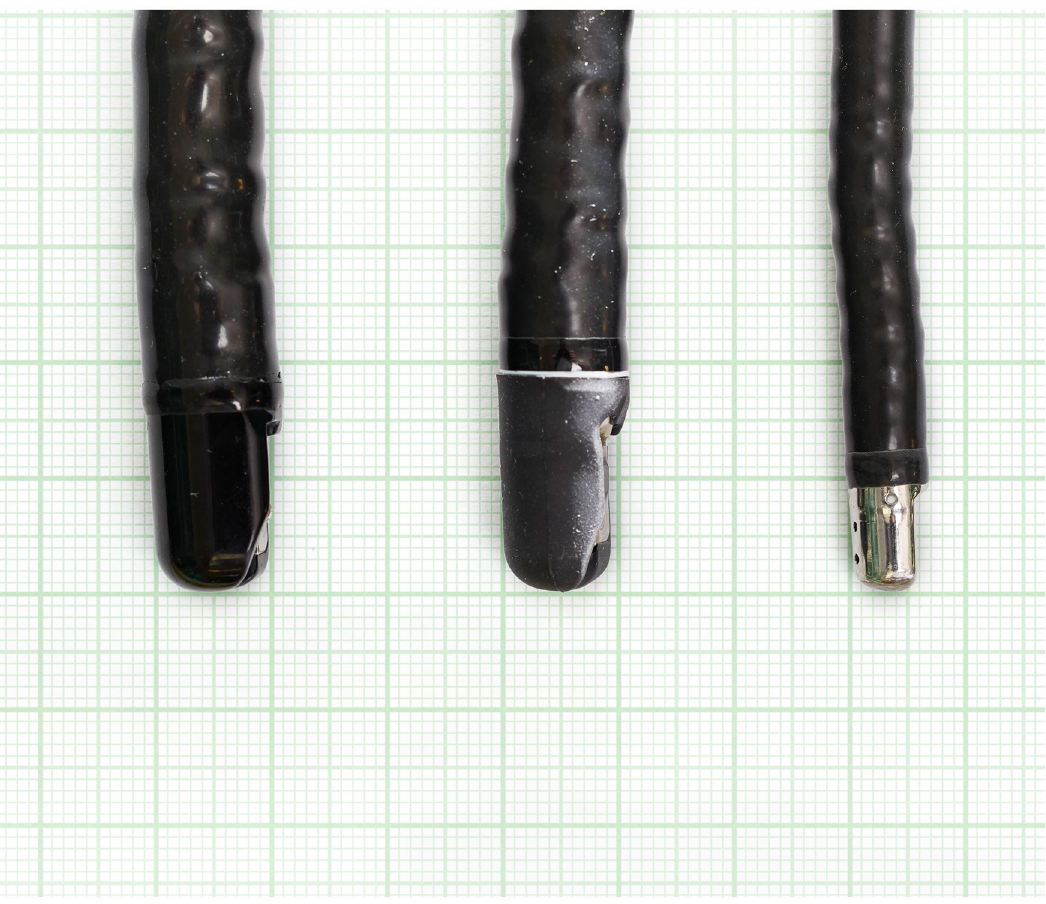
Fig 1. Olympus duodenoscopes: Therapeutic duodenoscope TJF-160 VR (left), diagnostic duodenoscope JF-140R (in the middle), pediatric duodenoscope Olympus PJF (right).